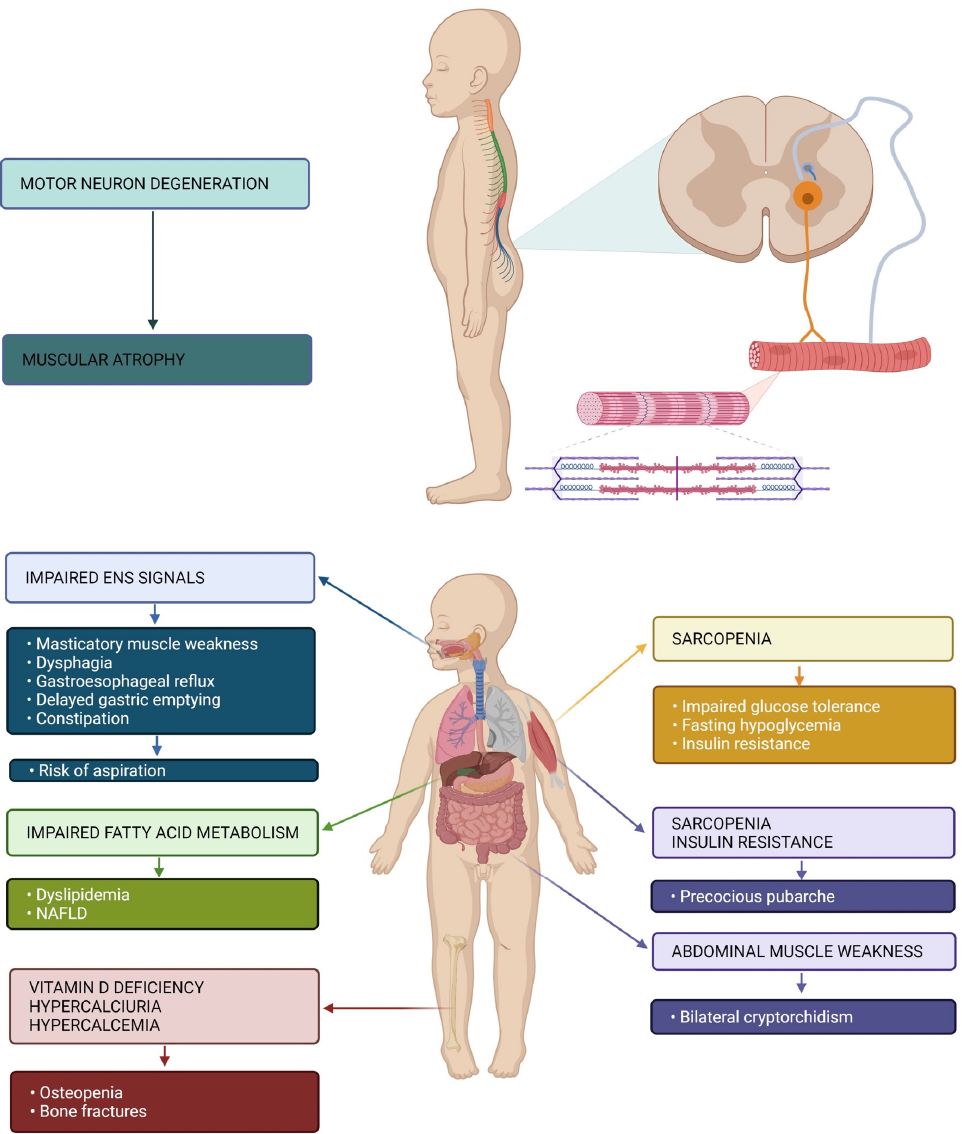
Figure 1. Pathophysiology of muscular atrophy and GI, metabolic and endocrine symptoms of patients with SMA1. Impaired enteric nervous system (ENS) signaling represents the main cause of GI manifestations (weakness of masticatory muscles, dysphagia, gastroesophageal reflux, delayed gastric emptying and constipation). These may be responsible for the risk of aspiration. Impaired fatty acid metabolism may cause dyslipidemia and non-alcoholic fatty liver disease (NAFLD). Altered bone metabolism may result in osteopenia and increased risk of bone fractures. Sarcopenia is responsible for metabolic manifestations (impaired glucose tolerance, fasting hypoglycemia and insulin resistance) and endocrine (precocious pubarche). Weakness of the abdominal muscles may also be responsible for bilateral cryptorchidism.